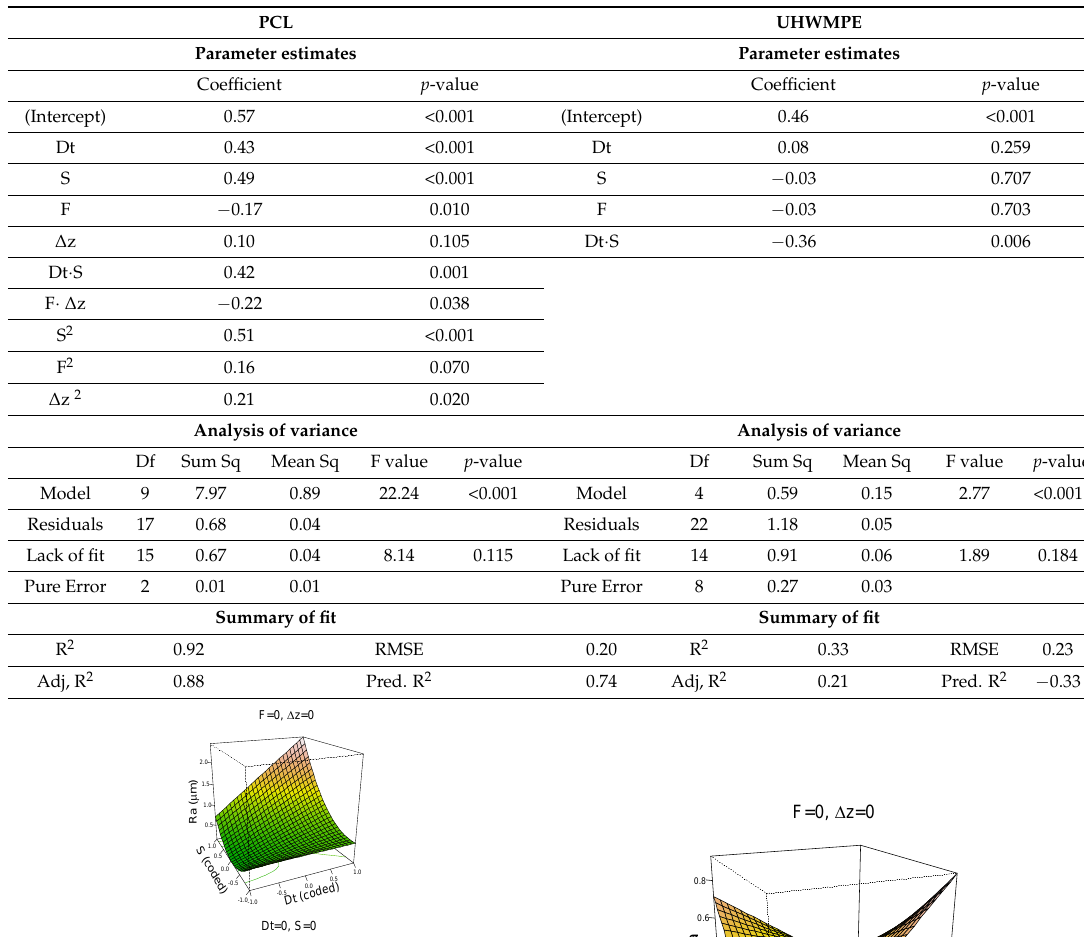
Table 4. Surface Roughness (Ra) model results.